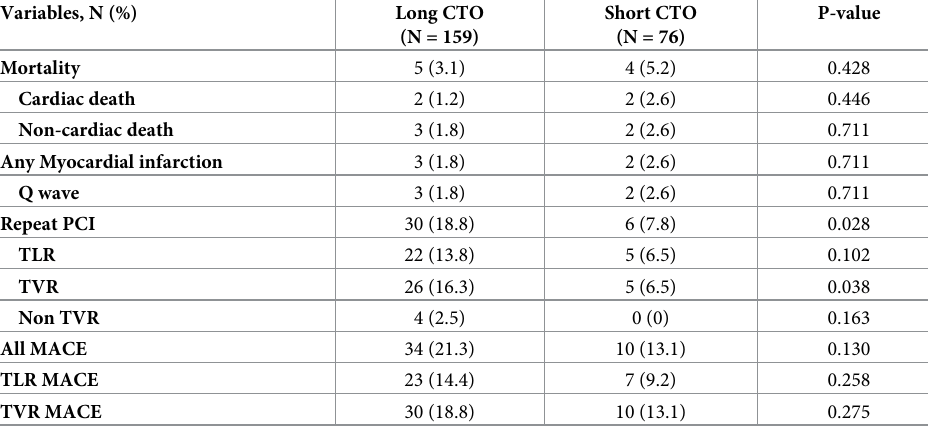
Table 3. Two-year clinical outcomes.